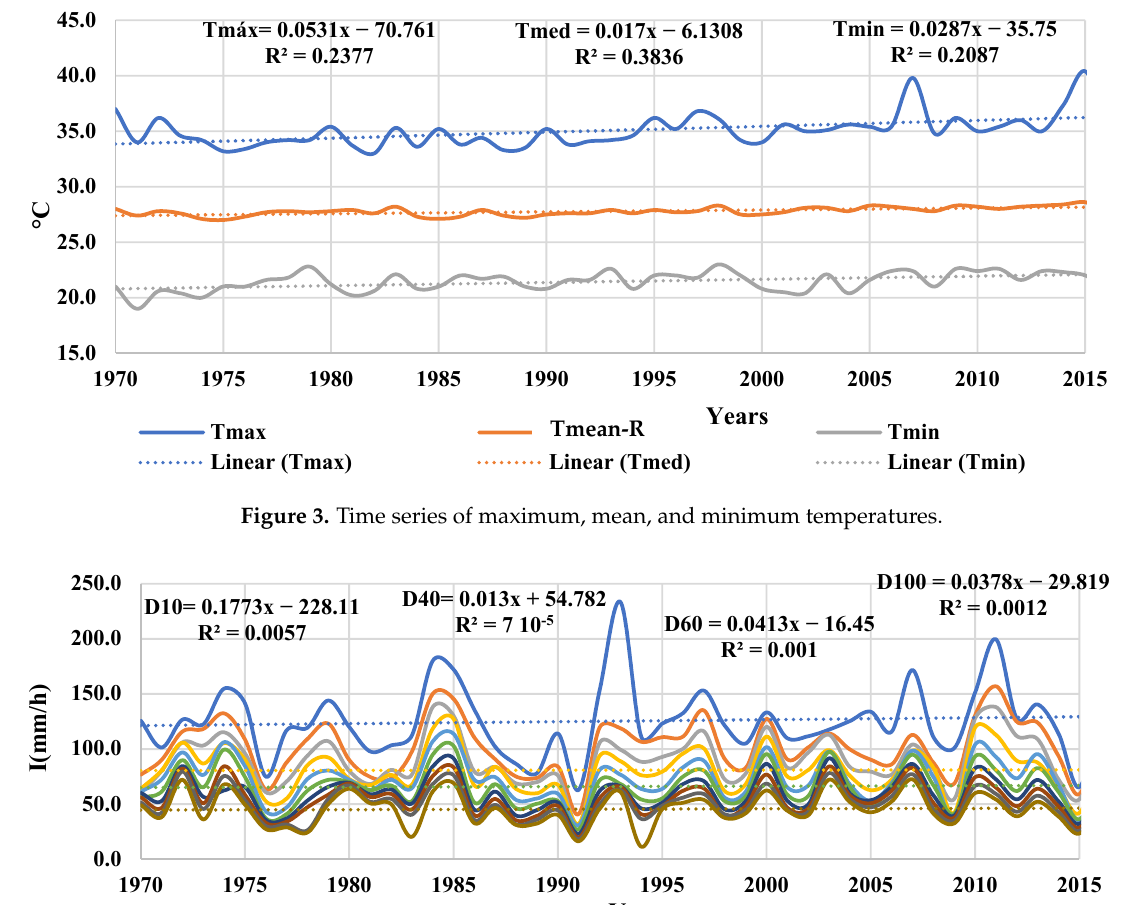
Figure 3. Time series of maximum, mean, and minimum temperatures.